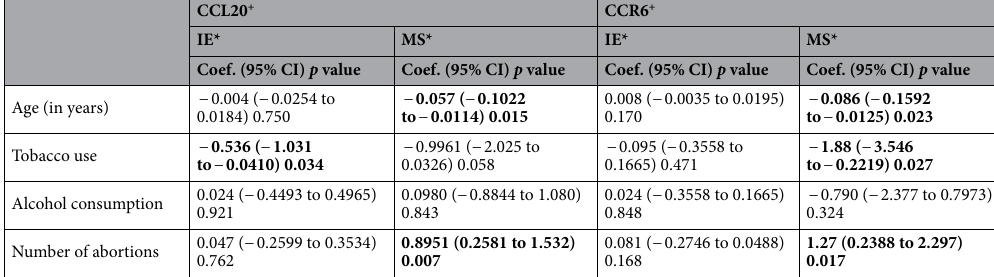
Table 3. Multiple linear regression analysis of CCL20 + and CCR6 + expressing cells. * IE intraepithelial, MS marginal stroma. The bold values mean statistical difference in the multiple linear regression analysis.